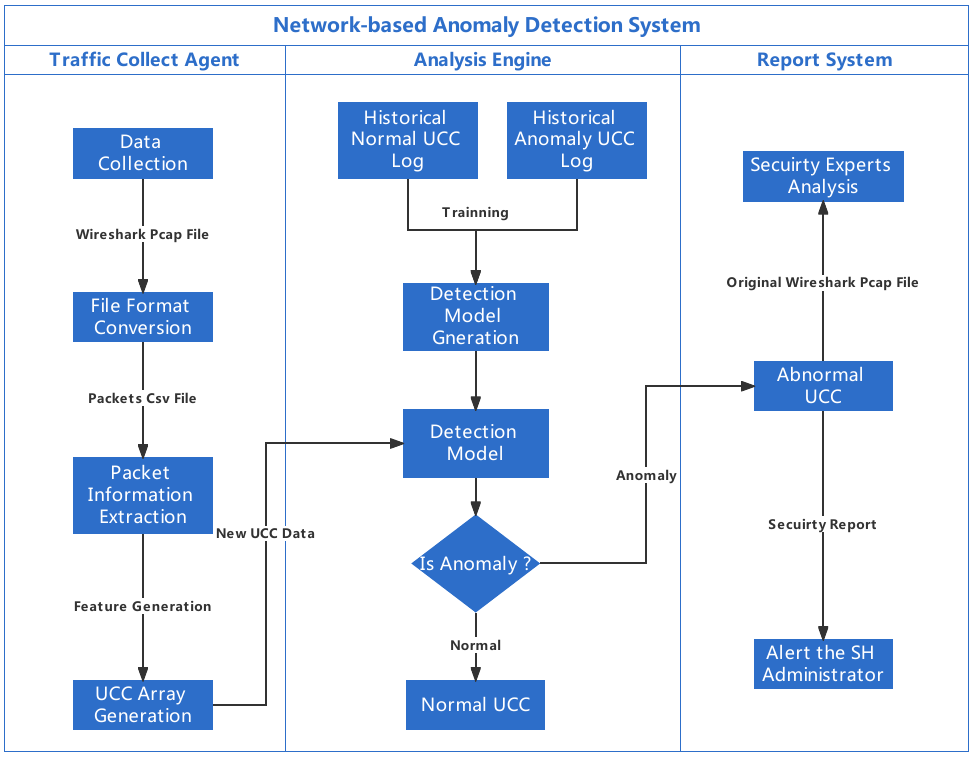
Figure 1. Network-based anomaly detection